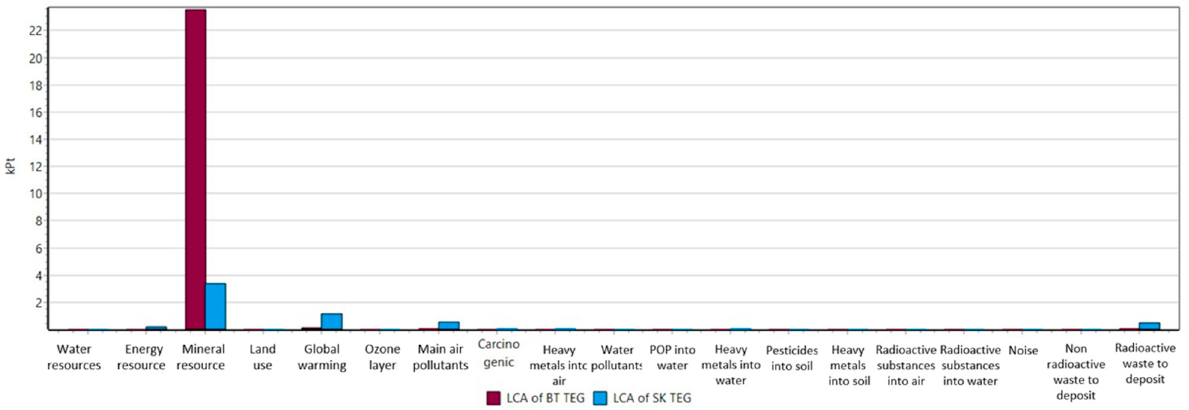
Figure 3. Comparison of LCA results for BT and SK modules (Ecological Scarcity 2013 Method) .